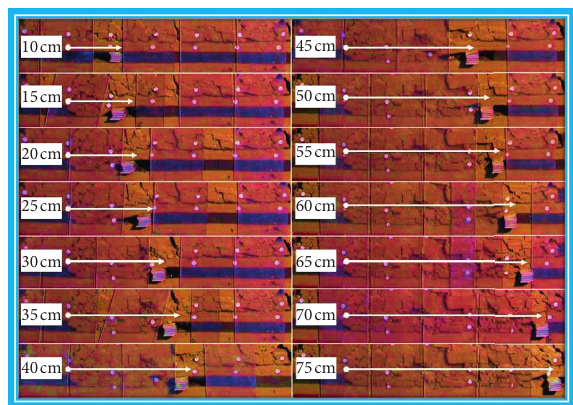
Figure 12: Roof collapse patterns at different distances.